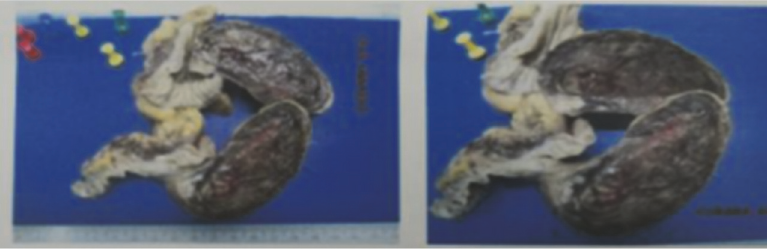
Figure 4: Gross pathological section of polyp.